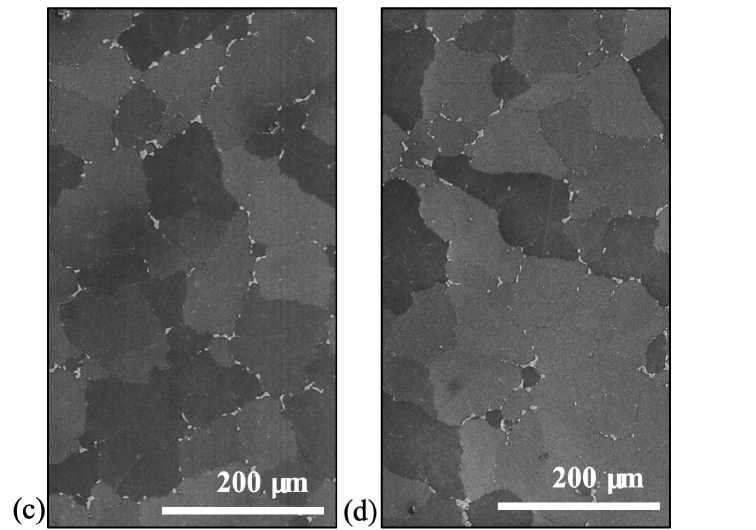
Figure 2. Typical as-aged microstructure for the DA2 alloy for the ( a ) non-grain-refined condition and grain-refined conditions with ( b ) 0.02, ( c ) 0.1, and ( d ) 0.2 wt.% Ti.